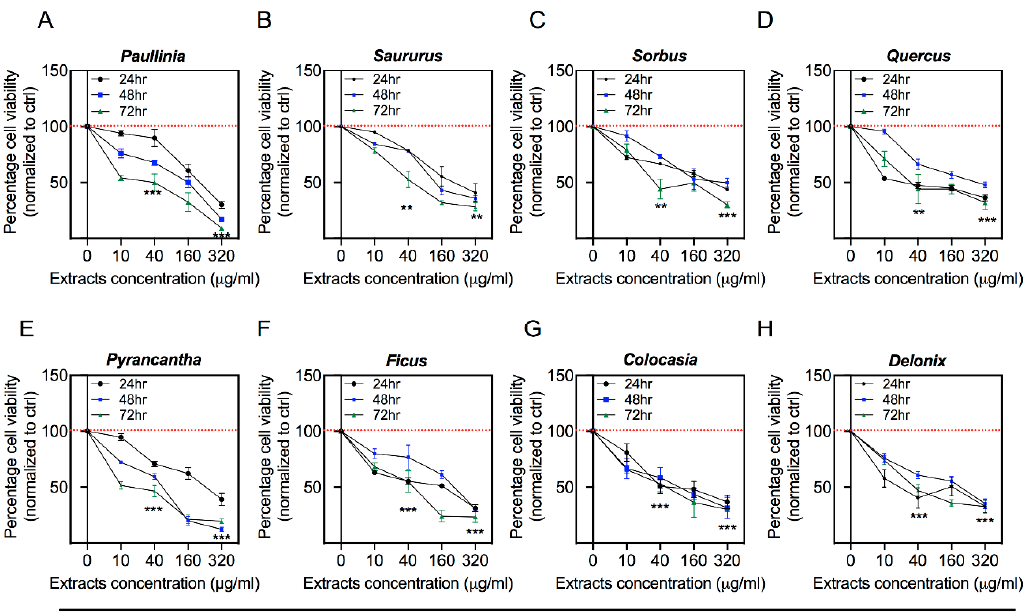
Figure 3. Cell viability screening analysis of different extracts from eight medicinal plants in human breast carcinoma MDA-MB231 cells. The alamarBlue assay was performed in Paullinia ( A ), Saururus ( B ), Sorbus ( C ), Quercus ( D ), Pyracantha ( E ), Ficus ( F ), Colocasia ( G ), and Delonix ( H ) extract-treated (0, 10, 40, 160, or 320 µg ∙ mL –1 ) cells after 24, 48, and 72 h of incubation. ** p < 0.01; *** p < 0.001. Untreated samples were used as controls for all tested plant extracts.